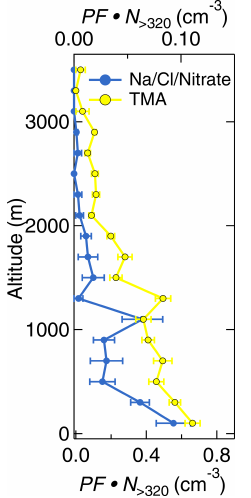
Figure 8. Vertically resolved aerosol composition measured by the ALABAMA during the Arctic air mass period. The panel represents the scaled ALABAMA number concentration (PF · N > 320 ) with the top axis referring to Na/Cl/Nitrate-containing particles (blue) and bottom axis referring to TMA-containing particles (yellow). Uncer- tainty analyses are given in Sect.